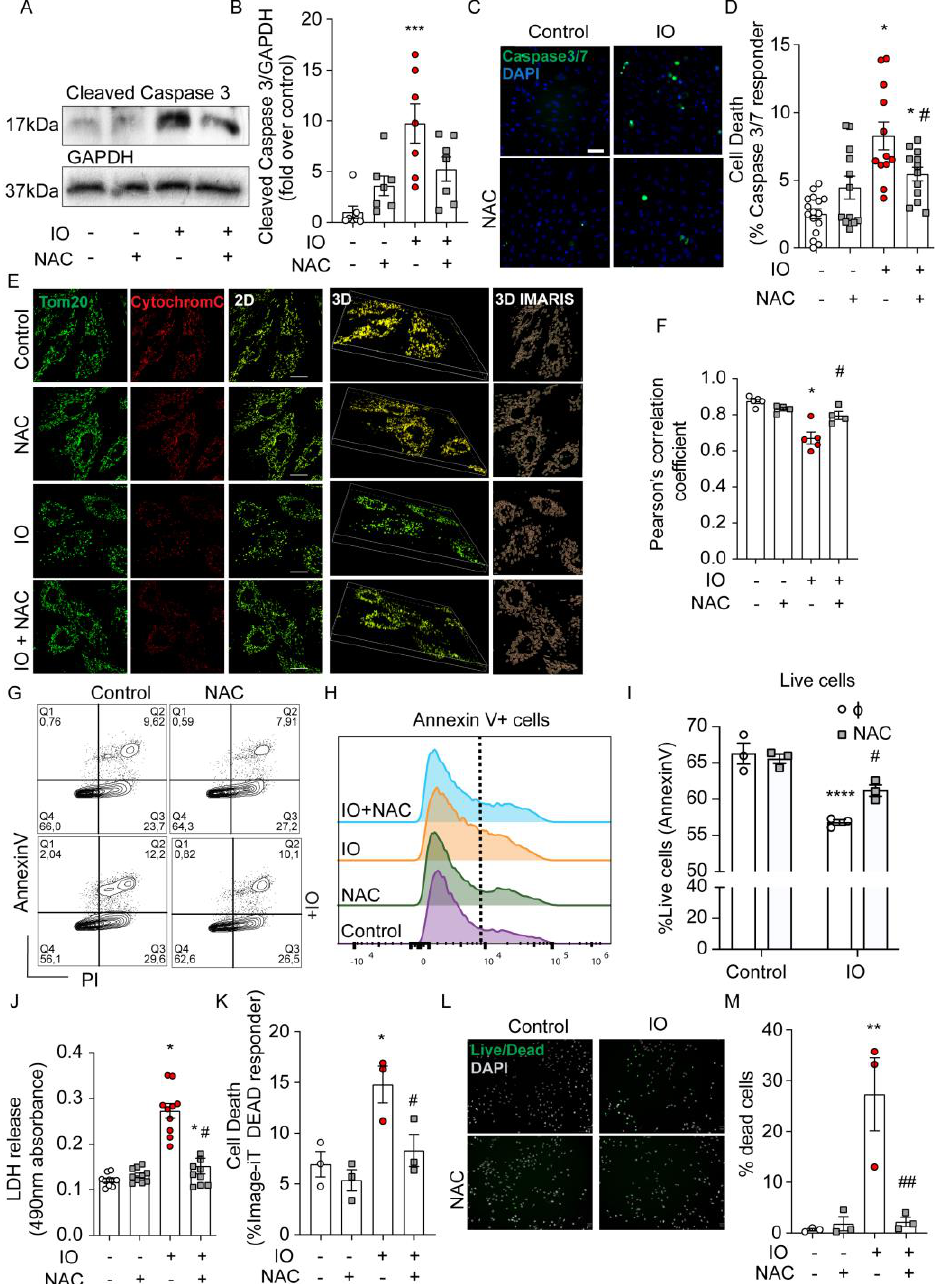
Figure 2. Iron overload activates apoptosis and increases H9c2 cell death. H9c2 cells were treated with FeSO 4 (100 µ M, 24 h) with or without NAC (500 nM, 24 h, with 30 min prior) co-treatment versus Control (DMEM + 0.5% FBS). ( A ) Western blot analysis of H9c2 lysates for the abundance for the apoptosis protein marker, cleaved-Caspase 3, in ( B ) Quantification of cleaved Caspase 3 band intensity (ImageJ, NIH Image) was normalized to GAPDH intensity for each condition and presented as fold over Control. ( C ) Representative CellInsight images from Caspase 3/7 Detection fluorescence assay to examine apoptotic cells with activated Caspase 3/7 cleavage (green nuclei) overlayed with all nuclei (marked by Hoechst). ( D ) Quantification of ( C ): Number of green positive nuclei as % of total nuclei in all cell wells (n = 4 experiments). ( E ) Examination of intrinsic apoptotic activation under IO by immunofluorescence: TOM20 (green) and Cytochrome C (red). Co-localiza- tion of cytochrome c (red) to the mitochondrial membrane (green). Representative images in 2D and 3D image are shown. For 3D, IMARIS software was used to render z-stack images (see Methods). ( F ) The TOM20 and Cytochrome C overlap was quantified in 25 cells per experiment by Pearson’s correlation coefficient for (n = 4 – 5, experiments). ( G ) Representative plots showing frequency of